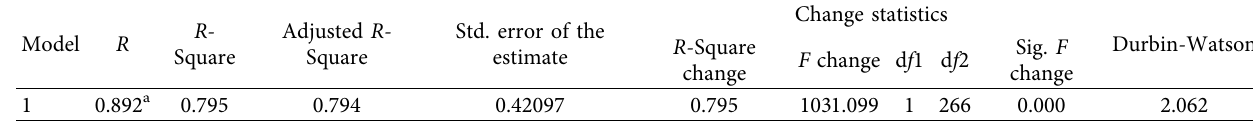
Table 4: Model summary.